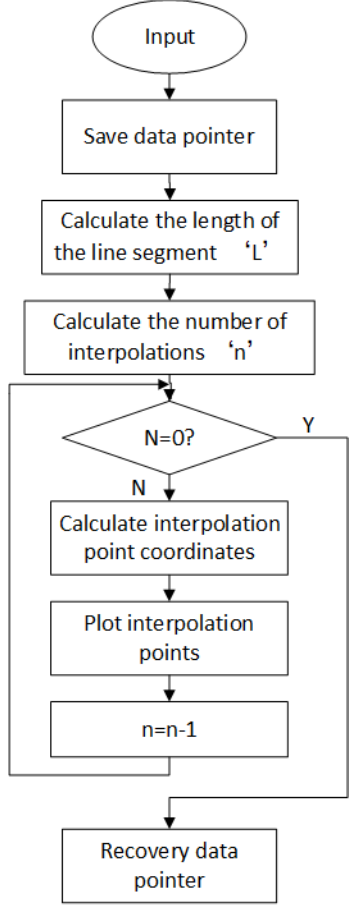
Figure 9. Polar coordinate linear interpolation process.